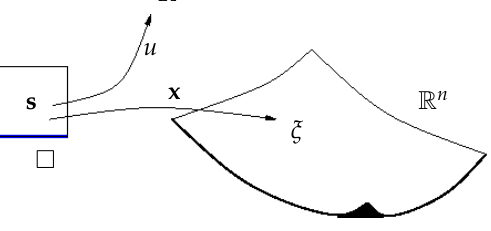
Figure 3. Isogeometric mapping u ◦ x − 1 . Algorithm 1: Construction of tri-3 C 1 splines